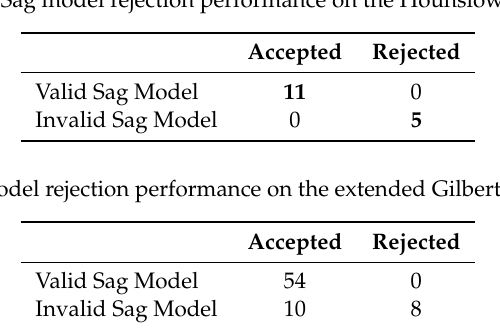
Table 3. Sag model rejection performance on the Hounslow dataset.